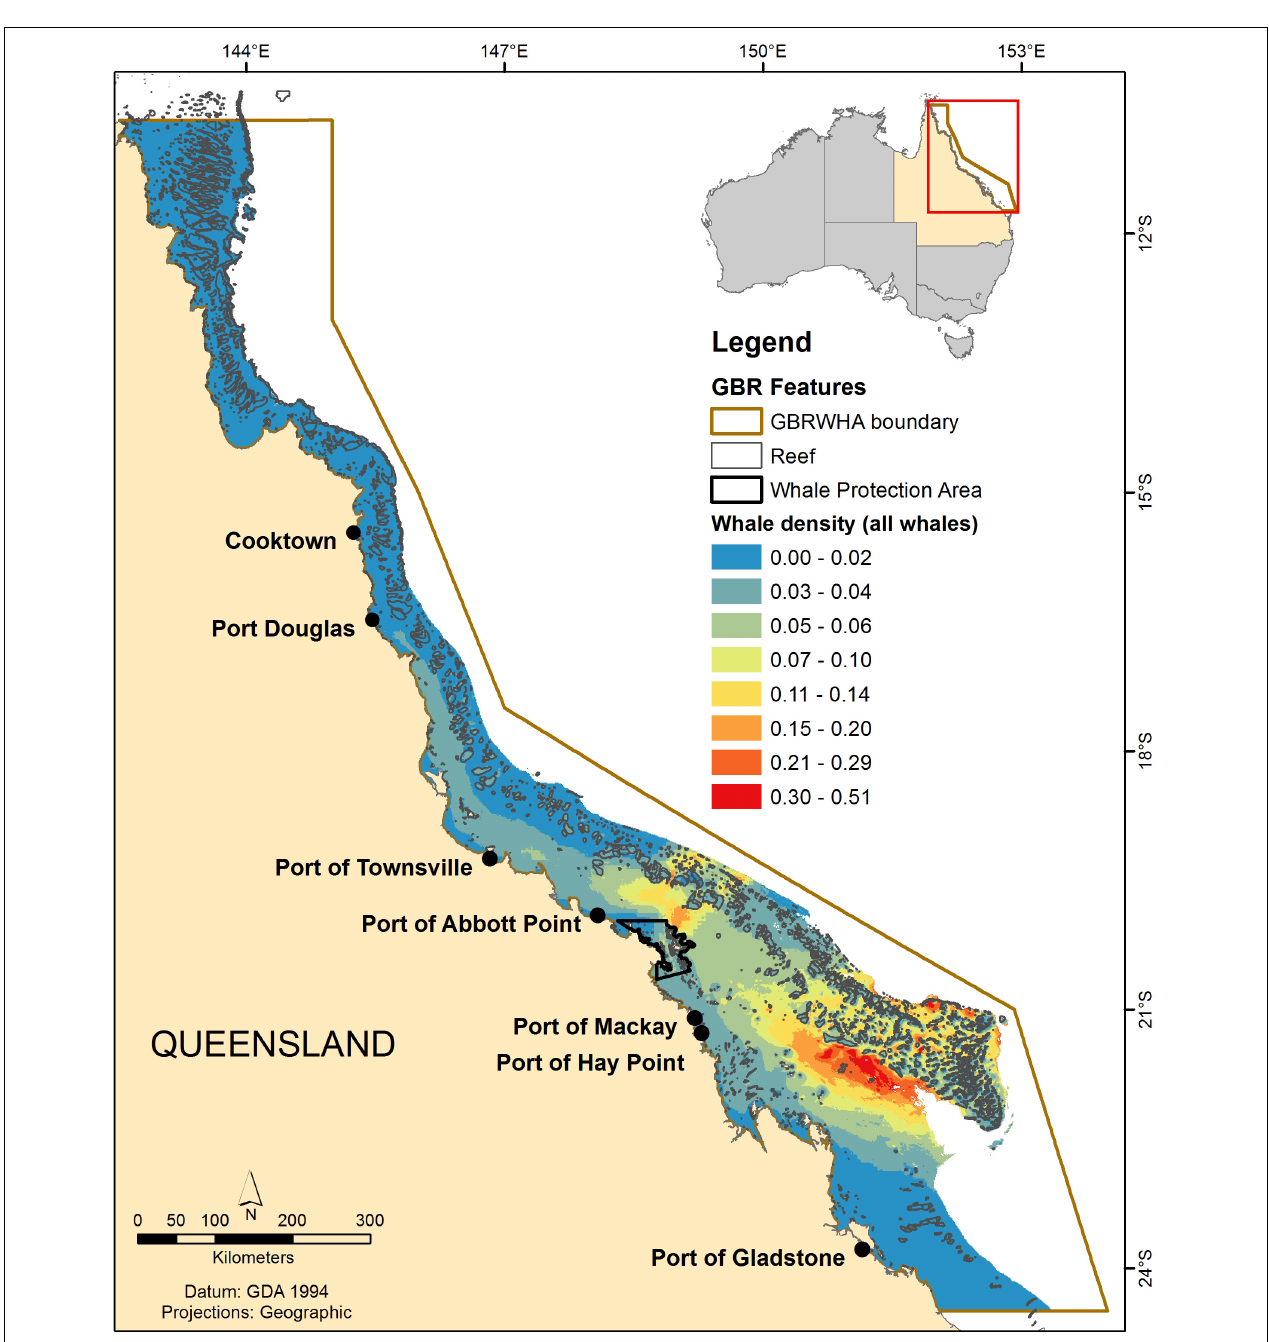
FIGURE 7 | Map of the whale protection area and modelled distribution and density of ‘all whale’ humpback whale groups during August 2012, with red areas indicating high whale density.